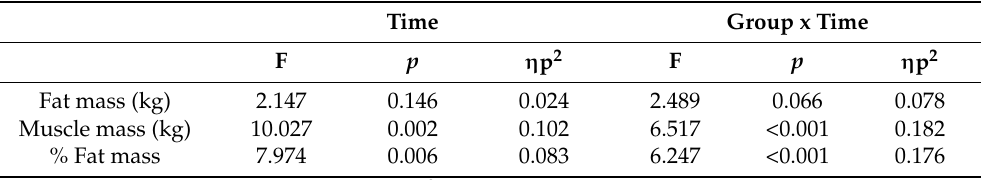
Table 6. Results of the ANOVA on body